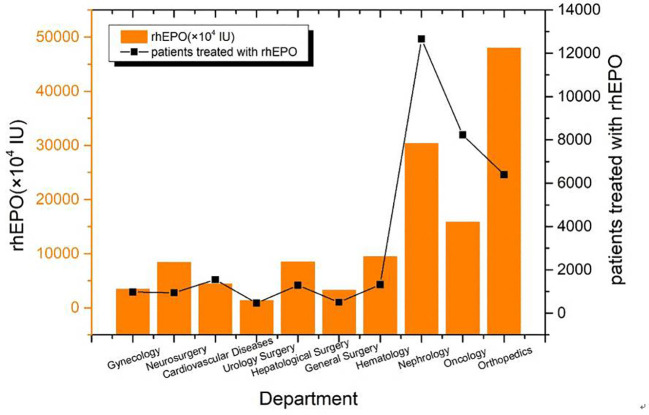
The total amount of rhEPO used by the main departments from 2009 to 2018.